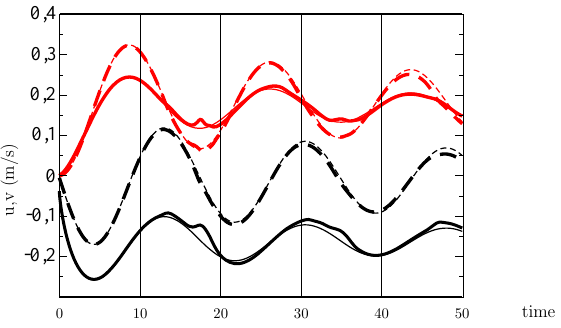
Fig. 5. Time evolution u-component (black) and v-component (red) at 0.5m (solid) and 25m (dashed) above ground for the 1-D (linear) model (thin lines) and the averages of the 3-D (turbulent) model (thick lines). For better comparison the velocities at 0.5m are mul- tiplied by a factor 20. (the thickness of the laminar Ekman layer is 10m).